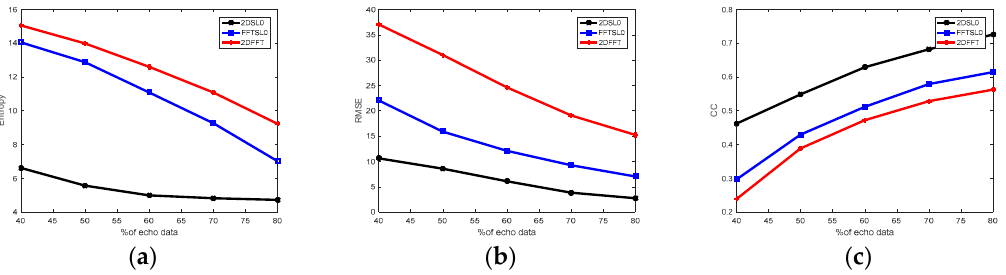
Figure 9. Bi-ISAR imaging results with different reconstruction methods versus measurements. Column 1 represents 2DFFT images, Column 2 represents FFTSL0 images, and Column 3 represents 2DSL0 images. Row 1 represents 50% of echo data, Row 2 represents 65% of echo data, and Row 3 represents 78% of echo data.